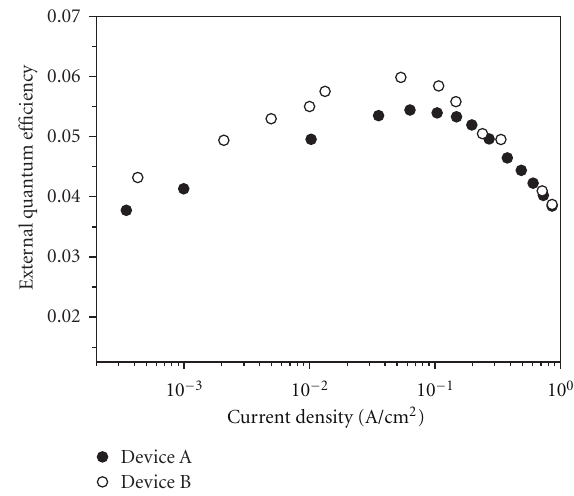
Figure 6: The external quantum e ffi ciencies of Devices A and B, which are plotted against current density.